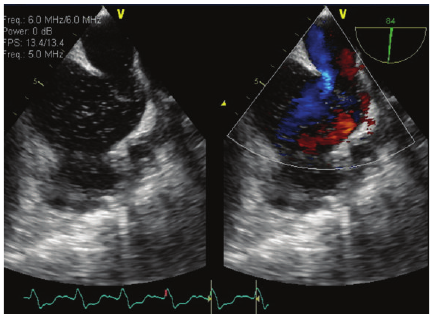
Figure 5: Color Doppler displaying sinus venosus